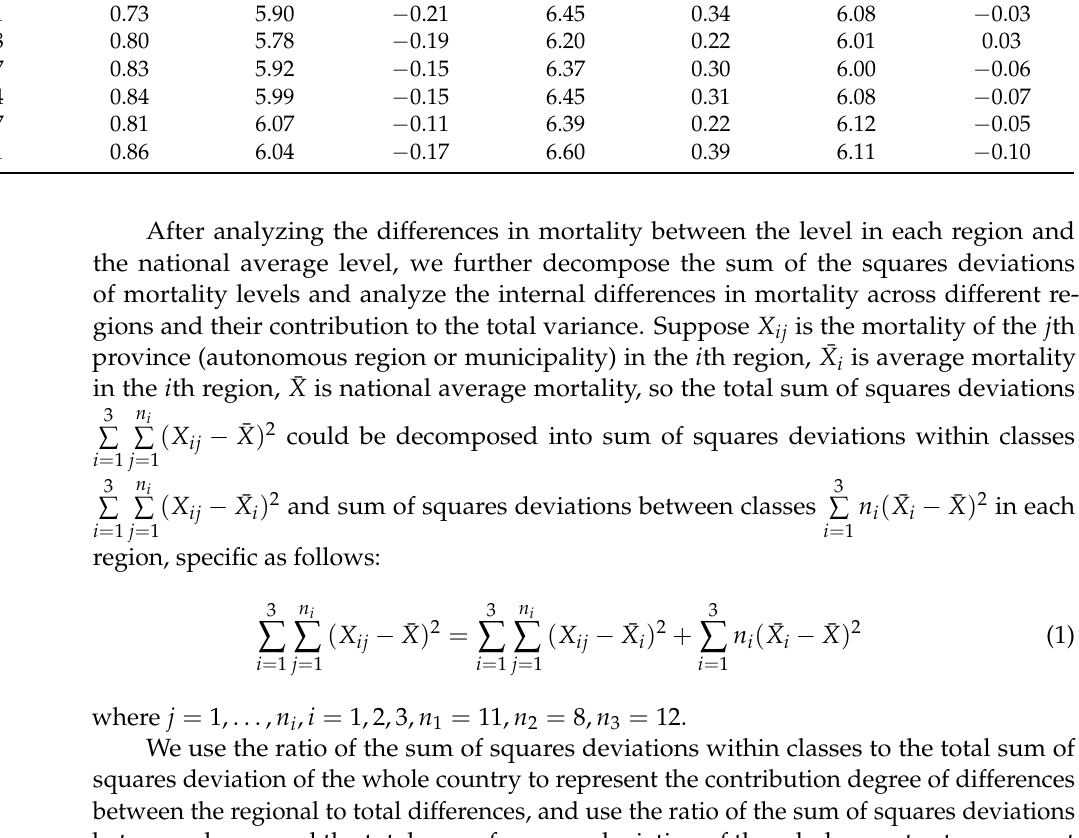
Differences in the Mean in the Nation